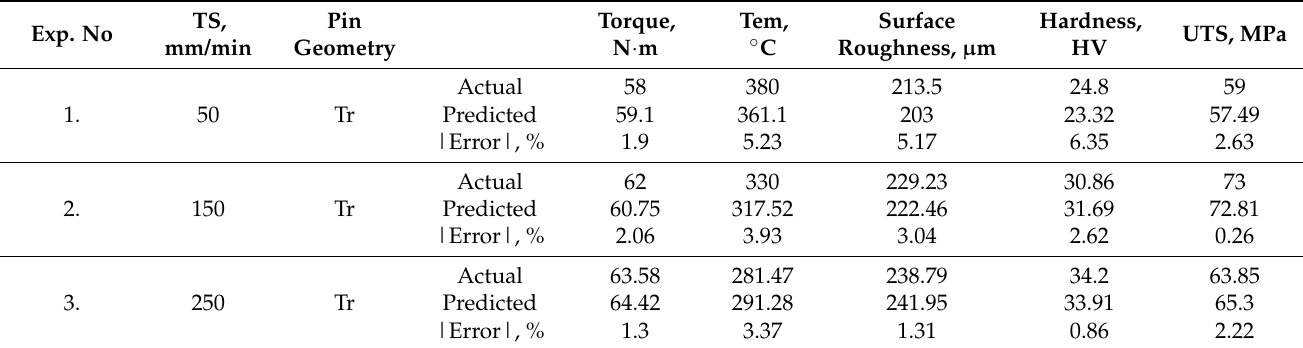
Table 9. Confirmation of test results for mathematical